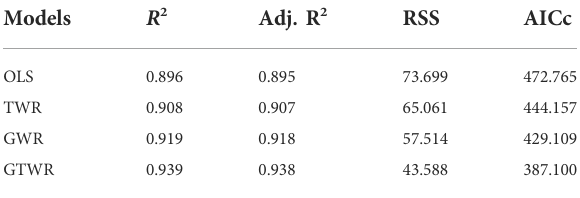
TABLE 5 Comparison of model test